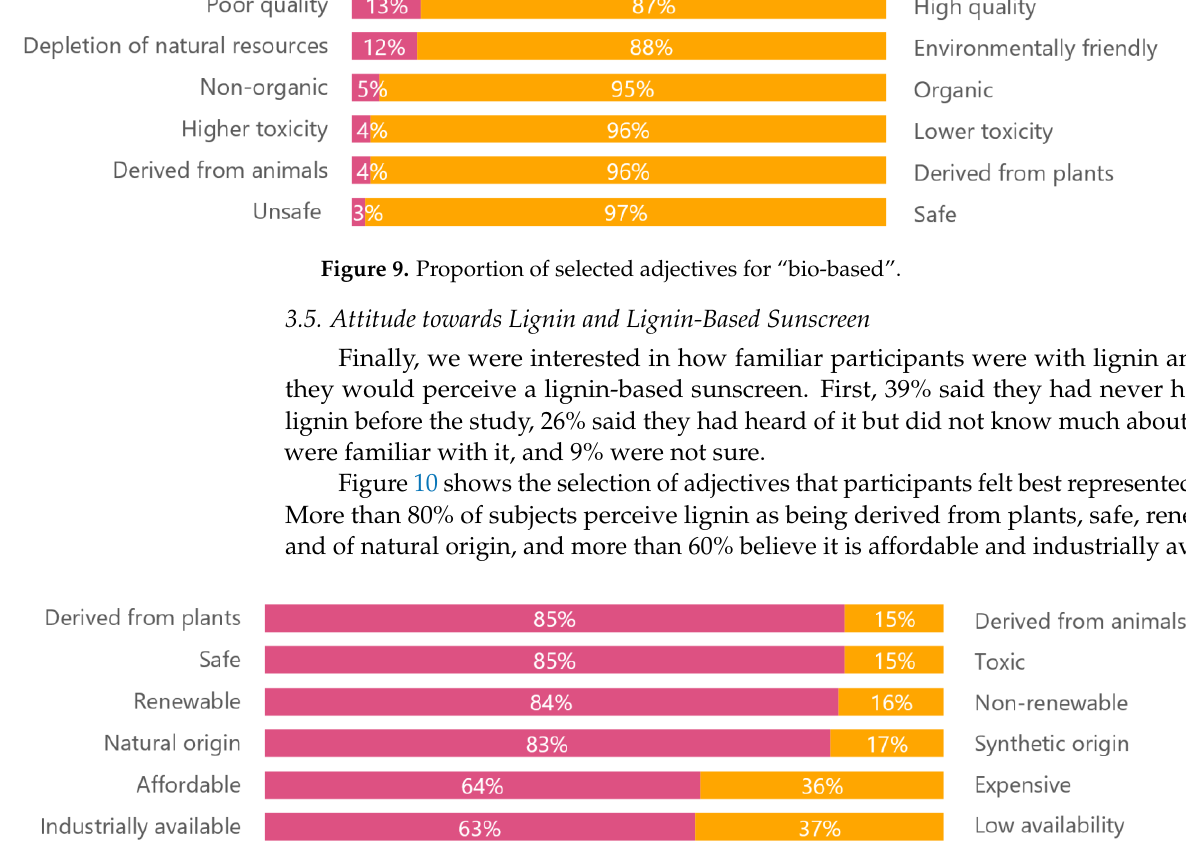
Figure 10. Proportion of sel ected adjectives for “lignin” .